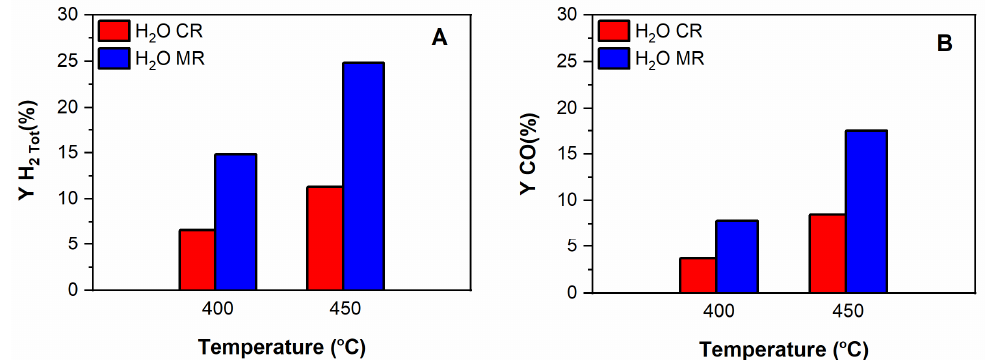
Figure 14. Effect of co-feeding H 2 O (2 vol.%) on the yields of H 2 ( A ) and CO ( B ) over Ru/ZrO 2 -La 2 O 3 catalyst at 400 and 450 °C in the MR and CR.; Feed composition: CH 4 :CO 2 :H 2 O:He = 10:10:2:78; Total flow rate = 100 mL/min: P = 1 bar. Sweep Gas: 300 mL/min (MR). Table 6. Conversions and yields for the Ru/ZrO 2 -La 2 O 3 catalyst measured in the activity essays of the DRM carried out in a Pd MR with and without H 2 O in the feed at 450 °C.